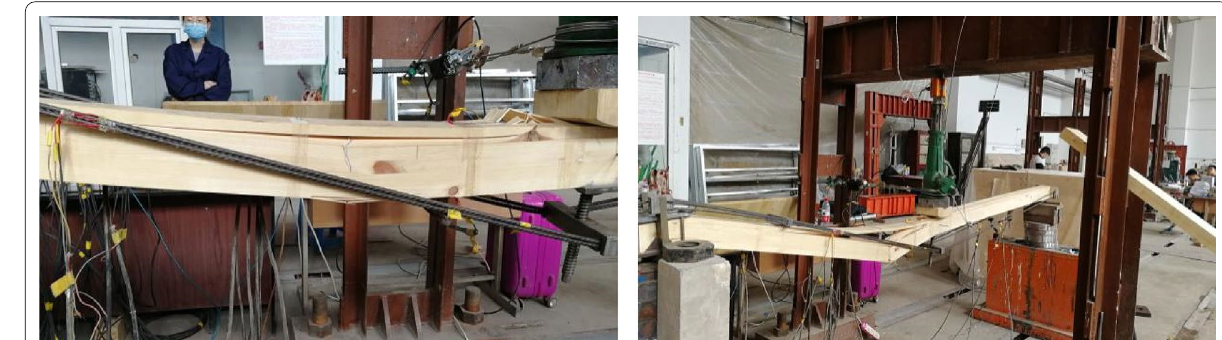
Fig. 6 Compression failure of the beam top